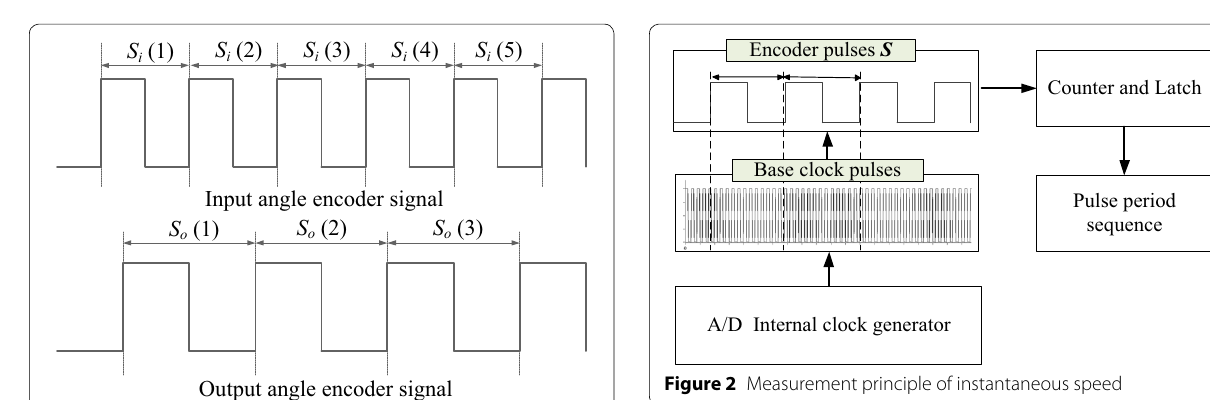
Figure 1 Pulse sequence of shaft angular displacement